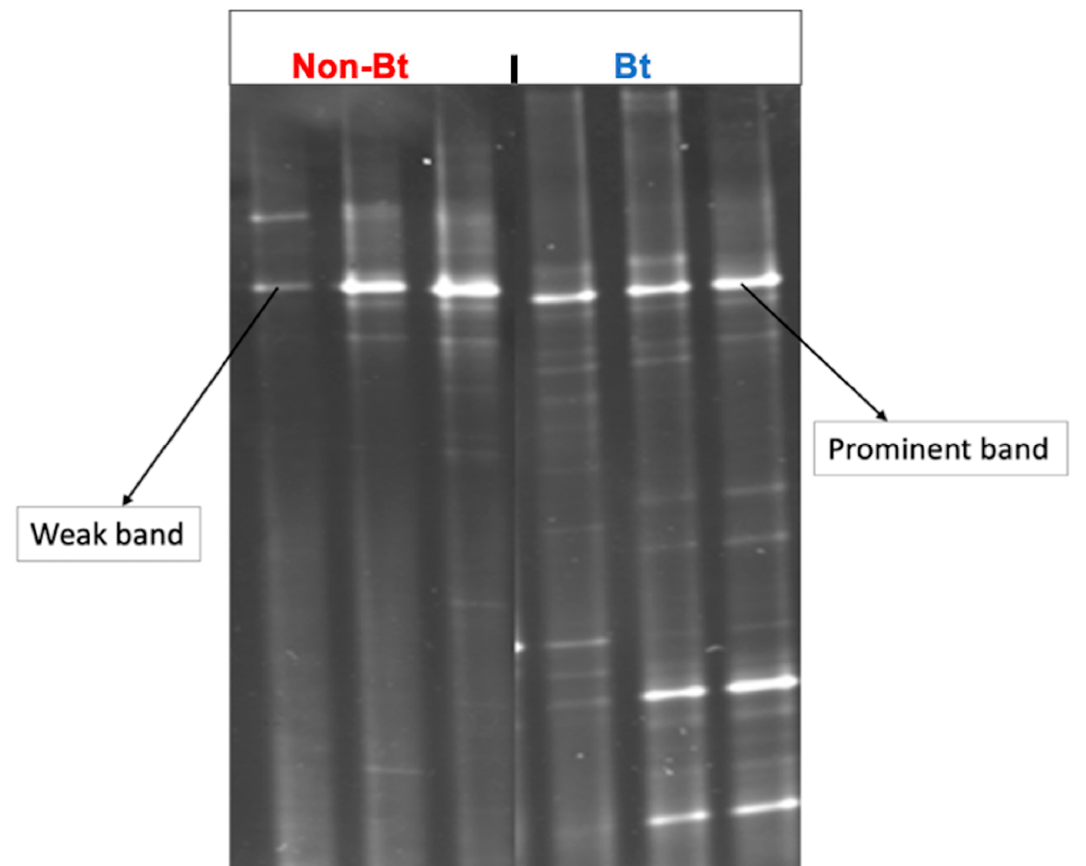
Figure 3. DGGE profiles of bacterial communities from the bollworm, H. zea , collected at the Upper Coastal Plain Research Station, Rocky Mount, NC (USA) in August 2016. Larvae were collected from non-Bt (PHY425RF) and Bt (PHY499WRF, Cry1Ac + Cry1F) cotton and processed the same day after transfer to the laboratory. DGGE was performed after the amplification of the bacterial V3 region of the 16S rRNA gene.